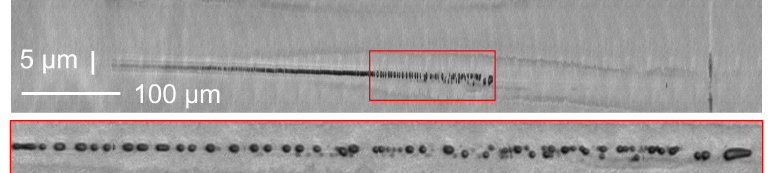
Figure 7. Strong bubbling in Eagle XG glass. Pulse duration is 3 ps, pulse energy 141 µ J. Please note image aspect ratio. Bottom inset shows a 1:1 zoom of marked area in panel